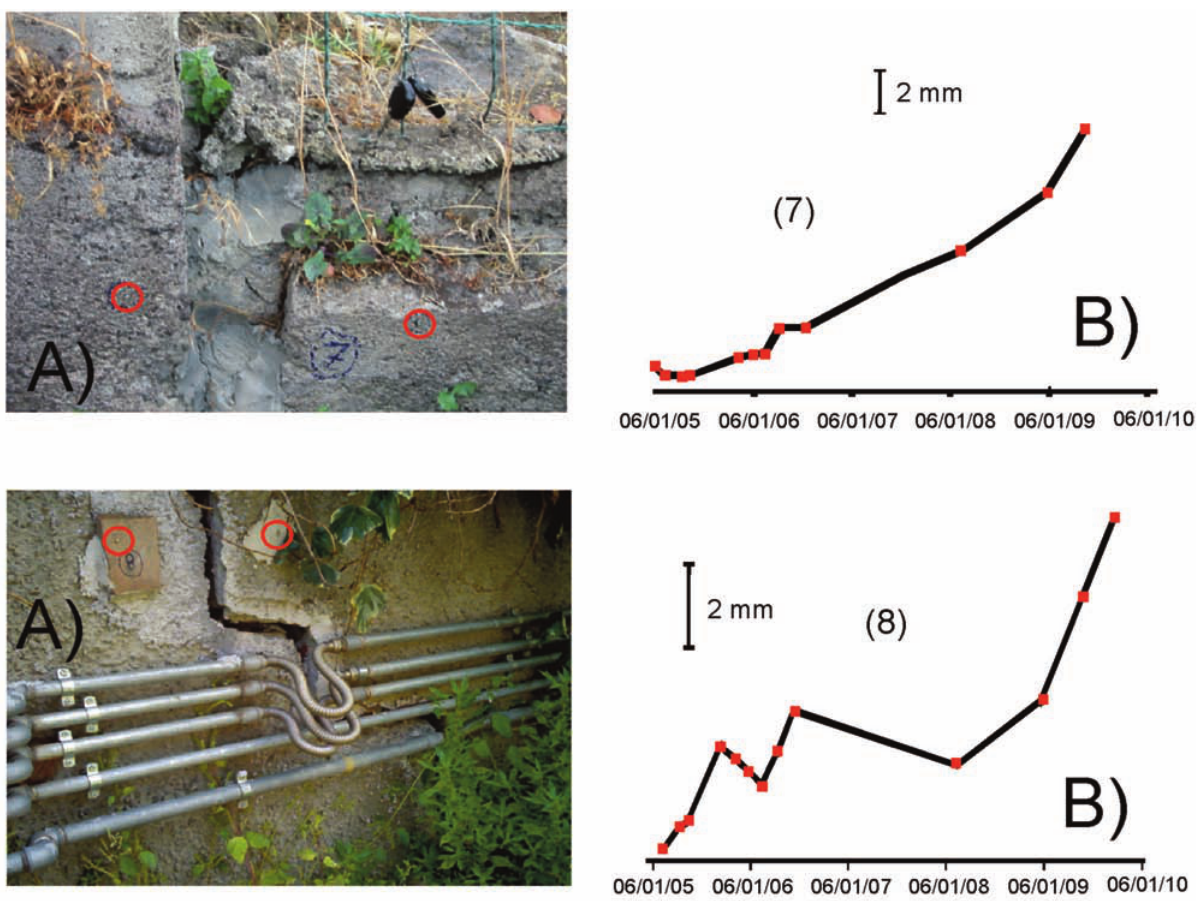
Figure 5. Photographs (A) and related data (B) of the n˚ 7 and n˚ 8 pairs of metal discs installed along the structure. Red circle evidence the metal discs. The graphs (B) indicates the changes in the distance between the metal